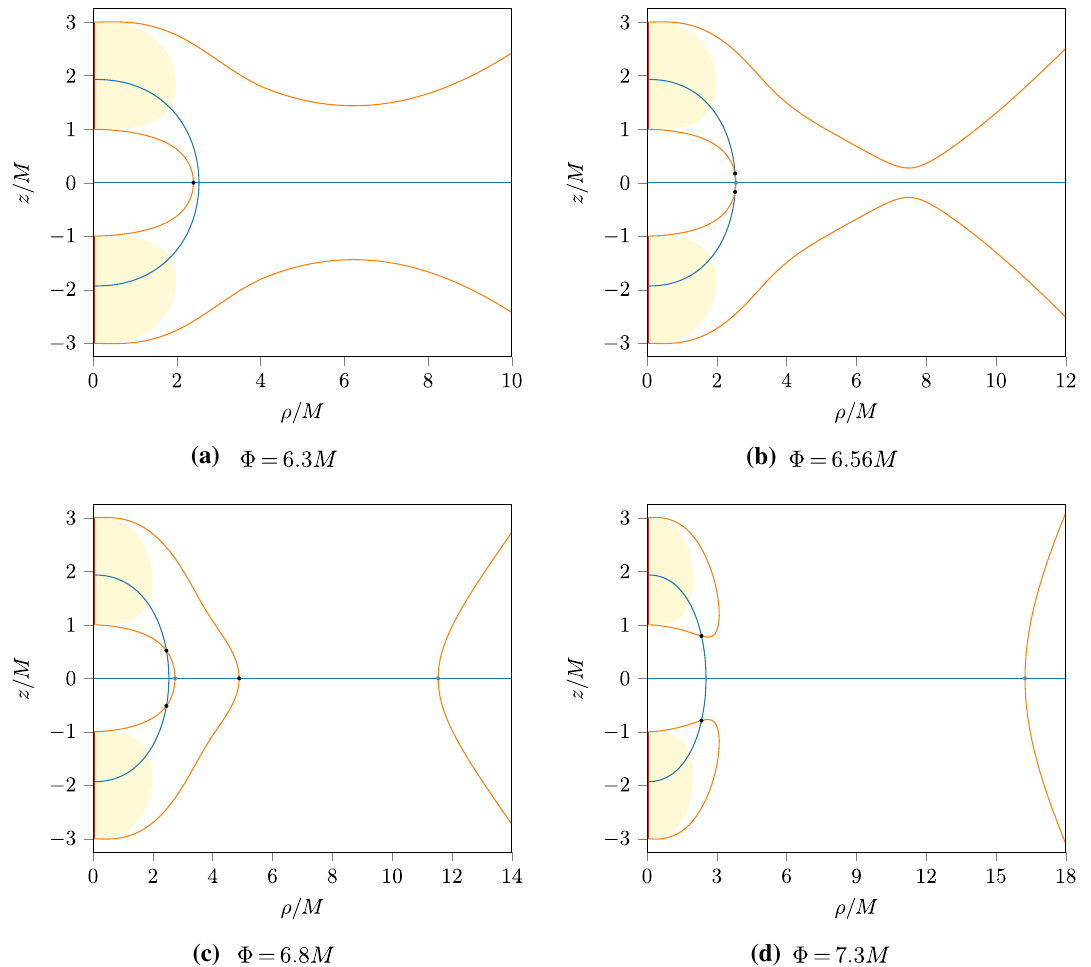
Fig. 16 Plots showing the points (ρ, z ) at which ∂ ρ V (ρ, z ) = 0 (orange curves) and ∂ z V (ρ, z ) = 0 (blue curves) for time-like geodesics, for L = M and four different values of (cid:9) as indicated. The intersectionpointscorrespondtocirculartime-likeorbits;theblackdots